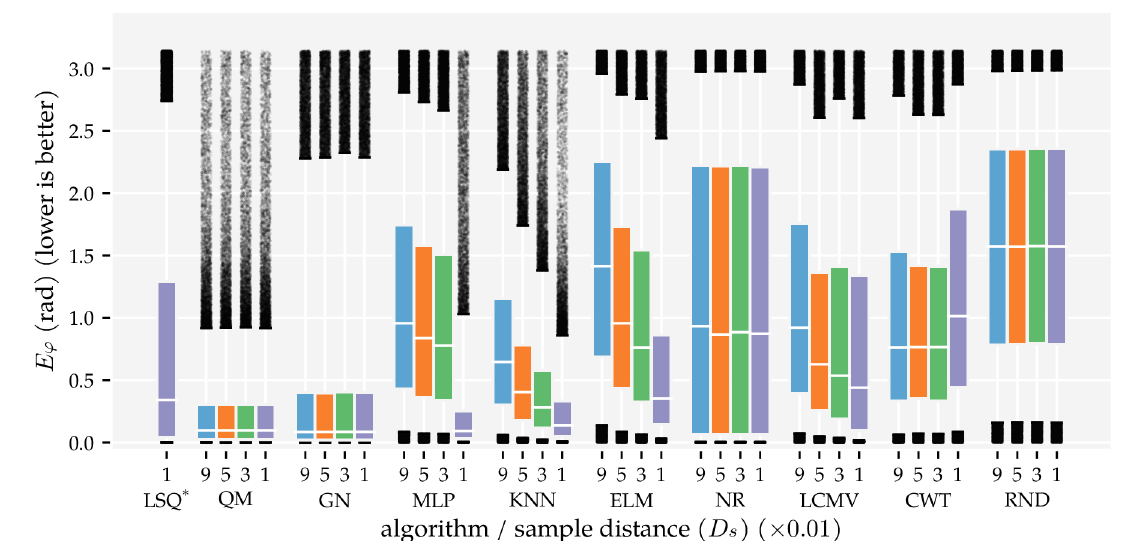
Figure 8. Boxplots of the movement direction error distributions for all dipole localisation algorithms in each condition of first analysis method. This analysis varied the minimum distance D s between source states in the training and optimi- sation set (see Section 2.3 and Table 1) and used the (x + y) sensor configuration at the σ = 1.0 × 10 − 5 ms − 1 noise level. The whiskers of the boxplots indicate the 5th and 95th percentiles of the distributions. Predictions with errors outside these percentiles are shown individually. LSQ* is based on the (x + y) condition in Analysis Method